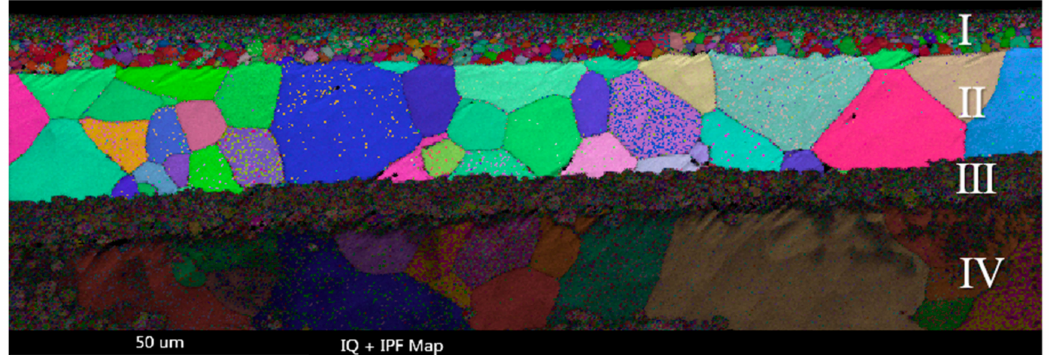
Figure 10. The EBSD reconstructive map of sample 2# after oxidized at 1200 ◦ C. Four layers divided in the longitudinal section of the coating marked I, II, III and